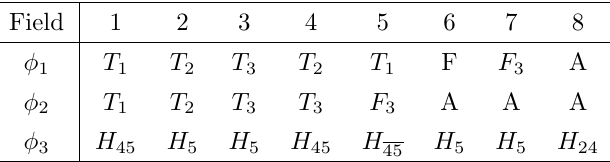
Table 2 . The list for dimension 4 operators corresponding to (cid:12)gure